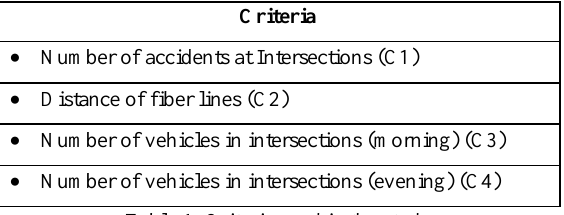
Table 1. Criteria used in the